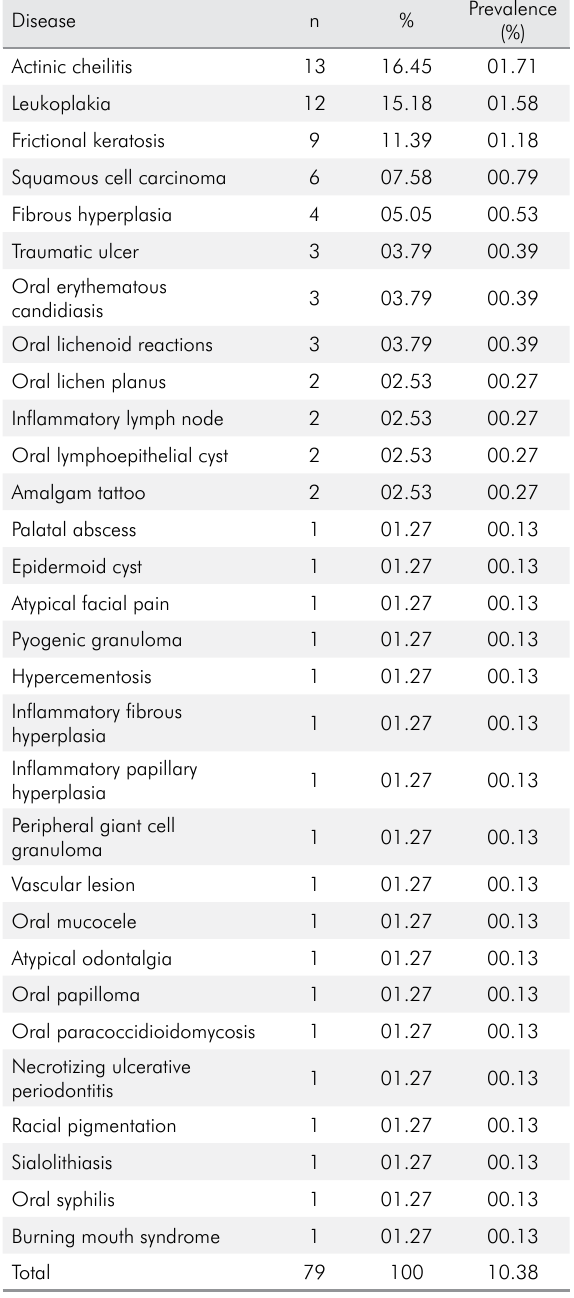
Table 4. Comparison of the presence of OPMD and SCC with sociodemographic and group variables (univariate analysis).